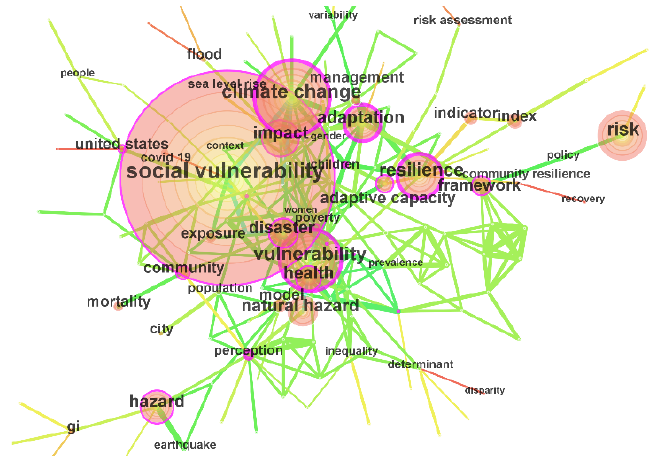
Figure 3. Keyword co-occurrence network of social vulnerability research from 1990 to 2021. The purple circle of the node indicates the key points with a node centrality greater